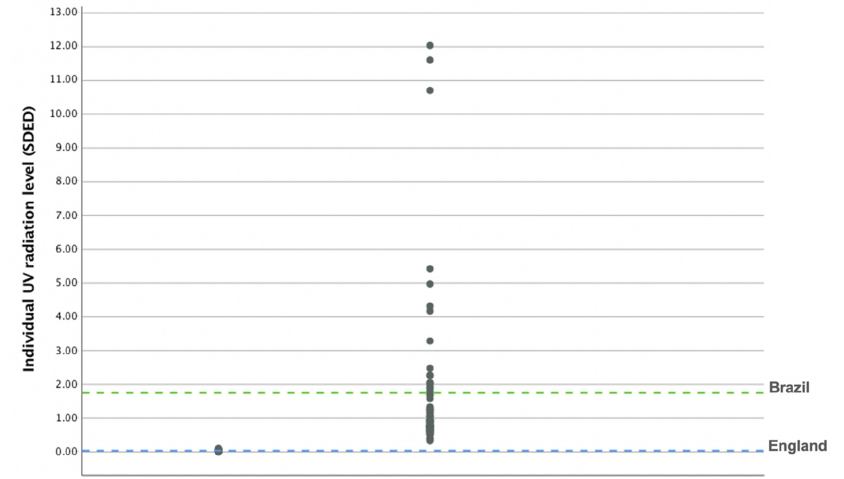
Figure 3. Daily individual Ultraviolet B radiation levels for women living in England ( n = 46) and women living in Brazil ( n = 69). Hashed lines represent mean daily individual UVB radiation level for women living in England (measured between October to March) and Brazil (measured between June to September).